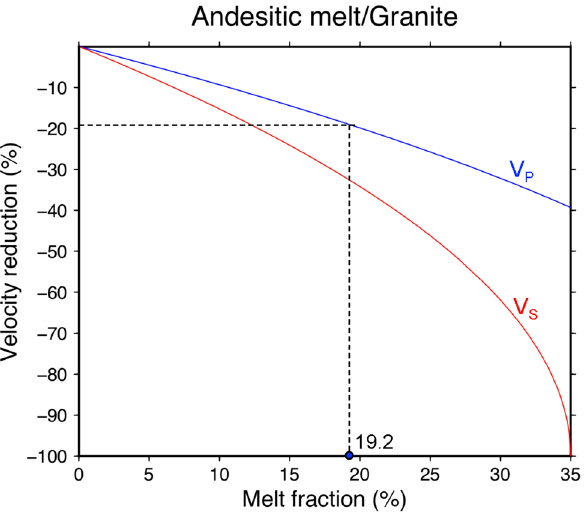
Figure 5. Melt fraction estimation for the magma reservoir. Blue and red curves are calculated relationship of P-wave and S-wave velocity reduction as a function of melt